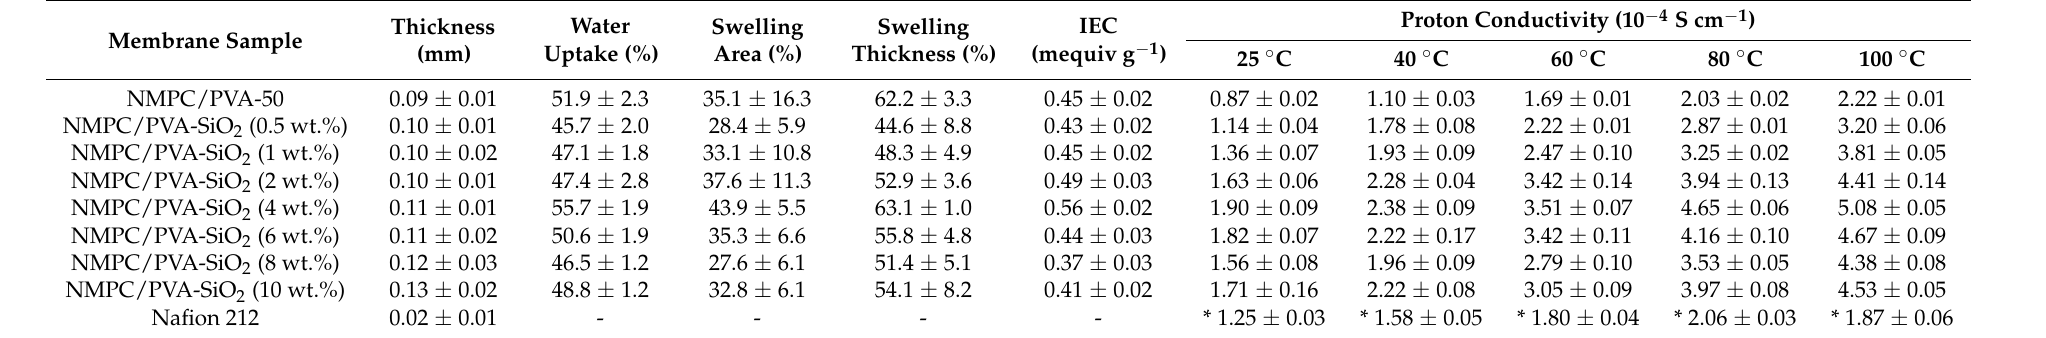
Table 2. Thickness, water uptake, swelling area, swelling thickness, IEC, and proton conductivity at different temperature (25–100 ◦ C) of the NMPC/PVA-50 and NMPC/PVA-SiO 2 composite membranes with different